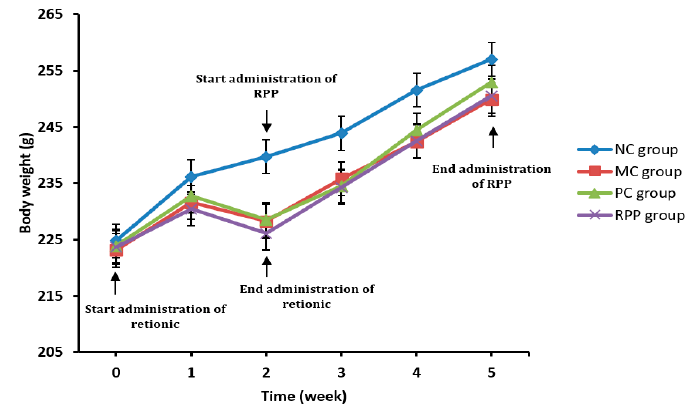
Figure 4. E ff ect of RPP on body weights of therats in di ff erent Figure 4. Effect of RPP on body weights of therats in different groups. Figure 4. Effect of RPP on body weights of therats in different groups.